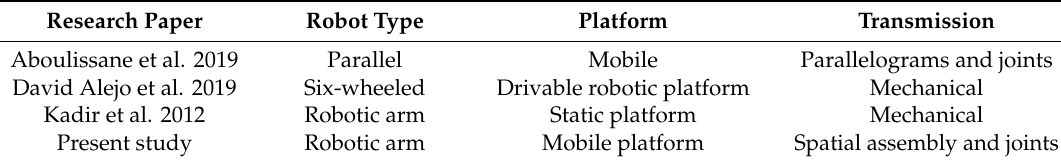
Table 3. Comparative parameters of the robotic arm analyzed in the present paper and other